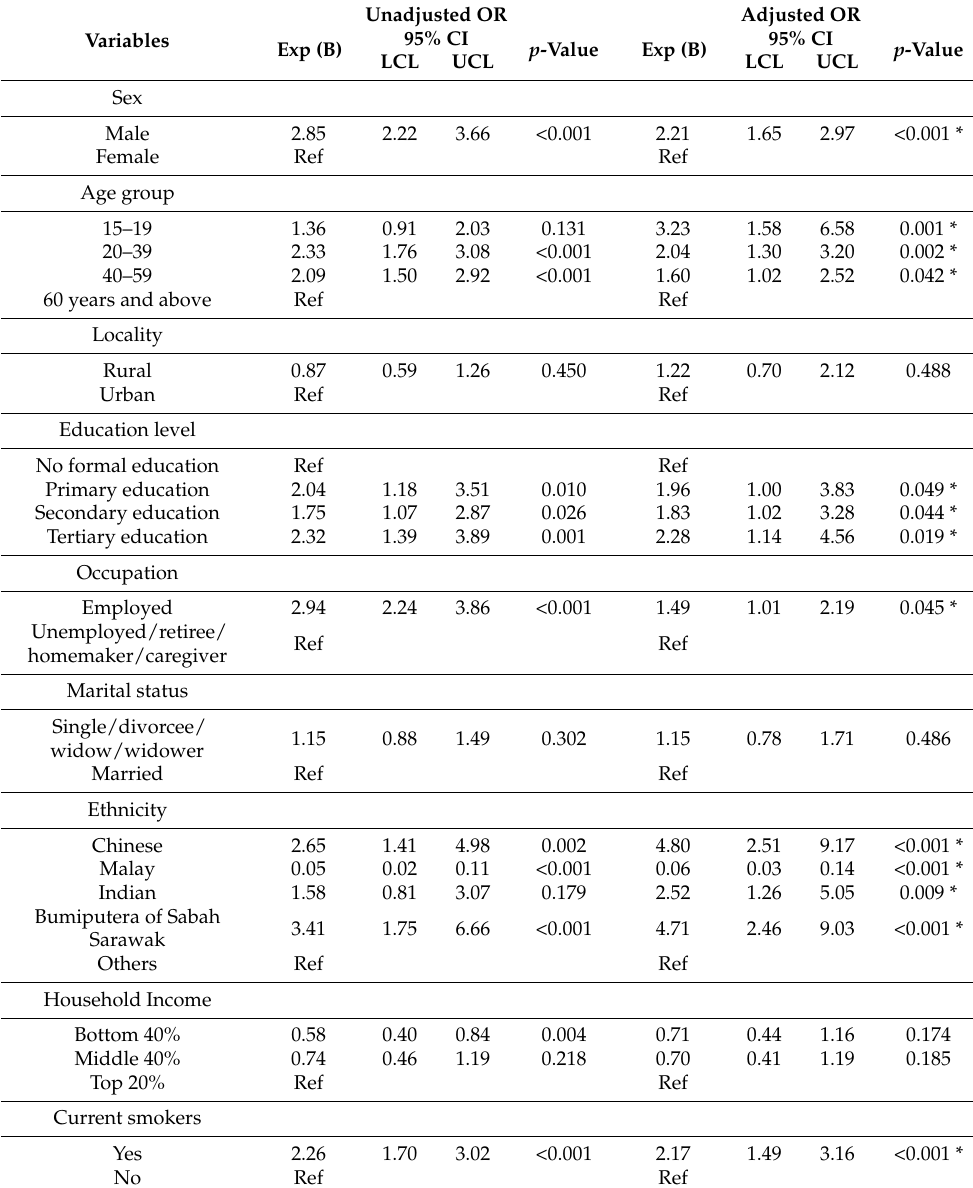
Table 2. Factors associated with alcohol drinking among adults aged 15 years and above in